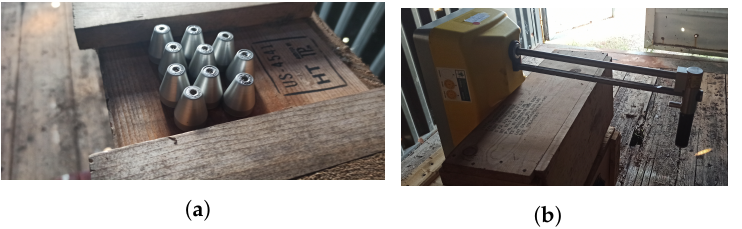
Figure 9. Radioactive sources used in the field tests: ( a ) 137 Cs sources centered inside the shipping container. ( b ) Troxler equipment oriented 90 ◦ centered inside the shipping container.